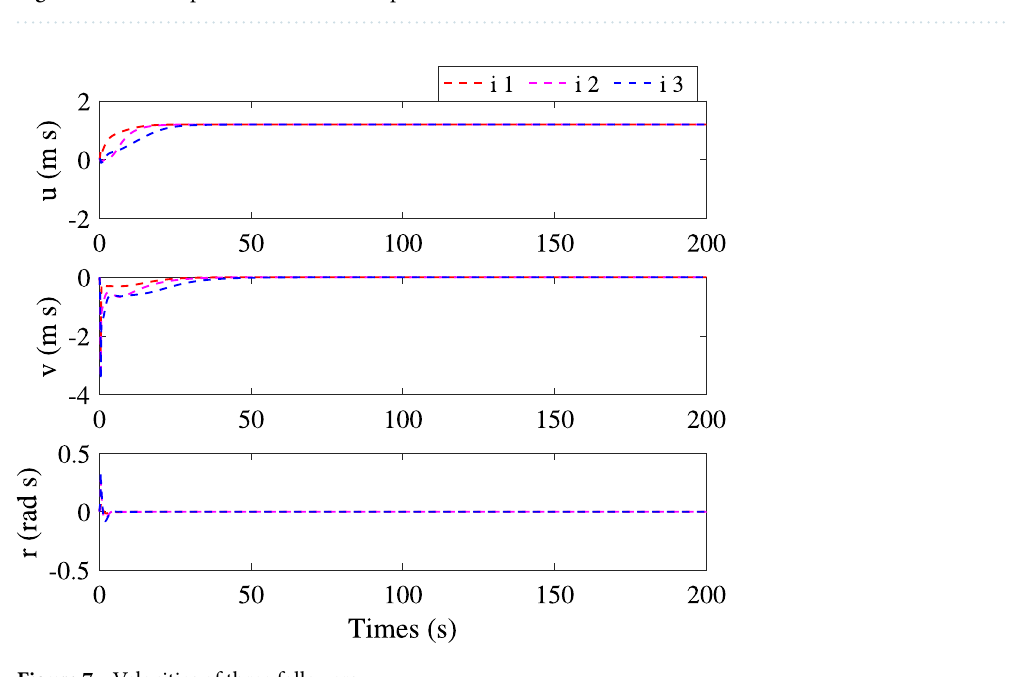
Figure 7. Velocities of three